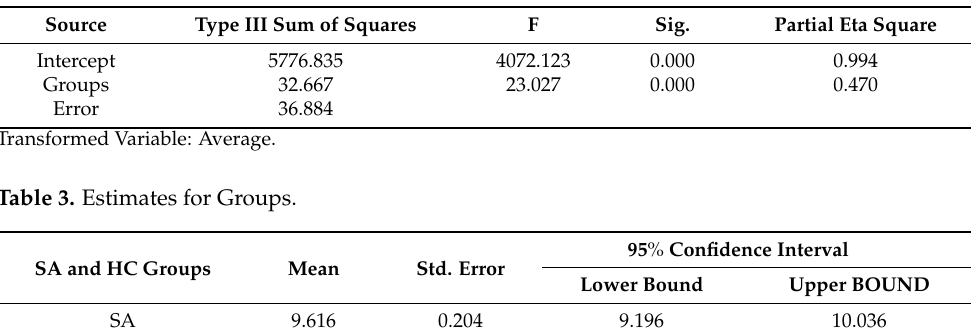
Table 2. Tests of Between-Subjects Effects for Alpha-Wave.